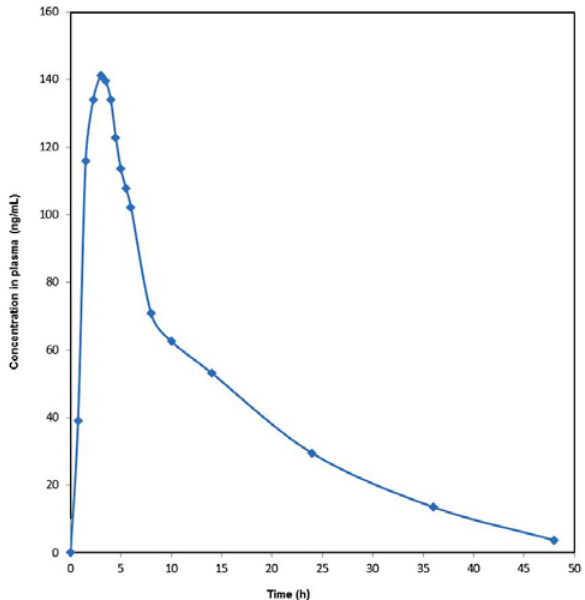
Figure 3: Pharmacokinetic profile of candesartan after admini- stration of the 32 mg candesartan